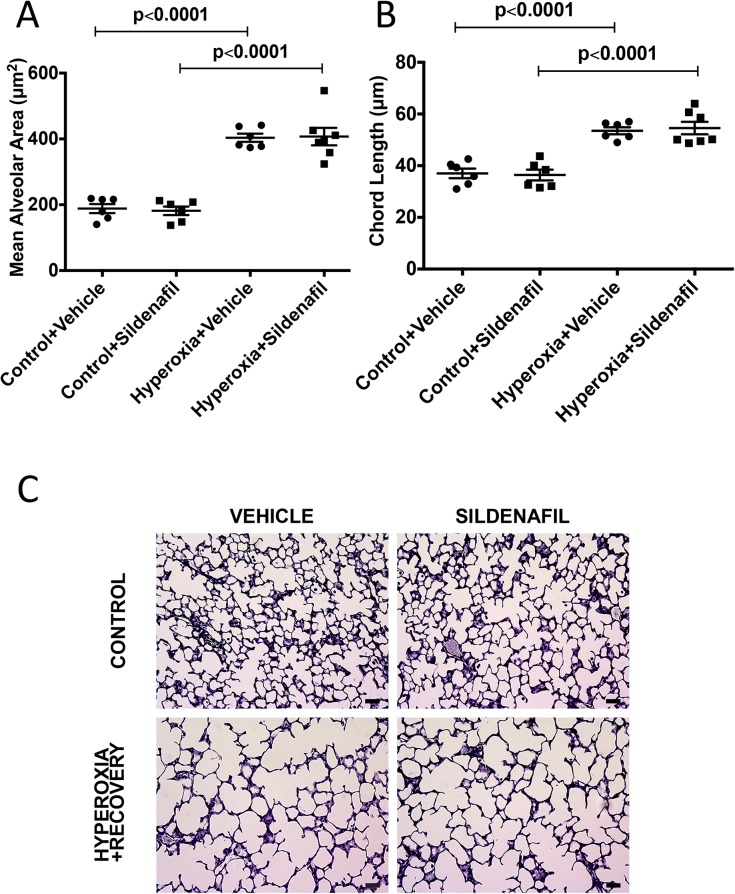
Sildenafil treatment during recovery does not ameliorate alveolar simplification.Mice were exposed to hyperoxia or room air for 14d, followed by recovery in room air for an additional 7d ± sildenafil or vehicle. Hematoxylin-stained sections were imaged, and (A) mean alveolar area and (B) chord length were measured (n = 6–7 animals per group). (C) Representative hematoxylin-stained lung sections are shown for vehicle-treated control, vehicle-treated hyperoxia + recovery, sildenafil-treated control, and sildenafil-treated hyperoxia + recovery. Bar = 50 μm. Data are expressed as dot plots with each dot representing individual animals with means and SEM represented by horizontal lines. Results were analyzed by ANOVA with post-hoc Bonferroni’s analysis.